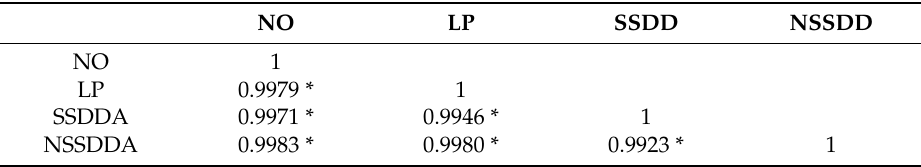
Table 4. Pearson’s correlation coefficients (R) among antioxidant activity (NO = Nitric oxide scavenging, LP = Lipid peroxidation, SSDD = Site specific deoxyribose deprivation, NSSDD = Non-site specific deoxyribose